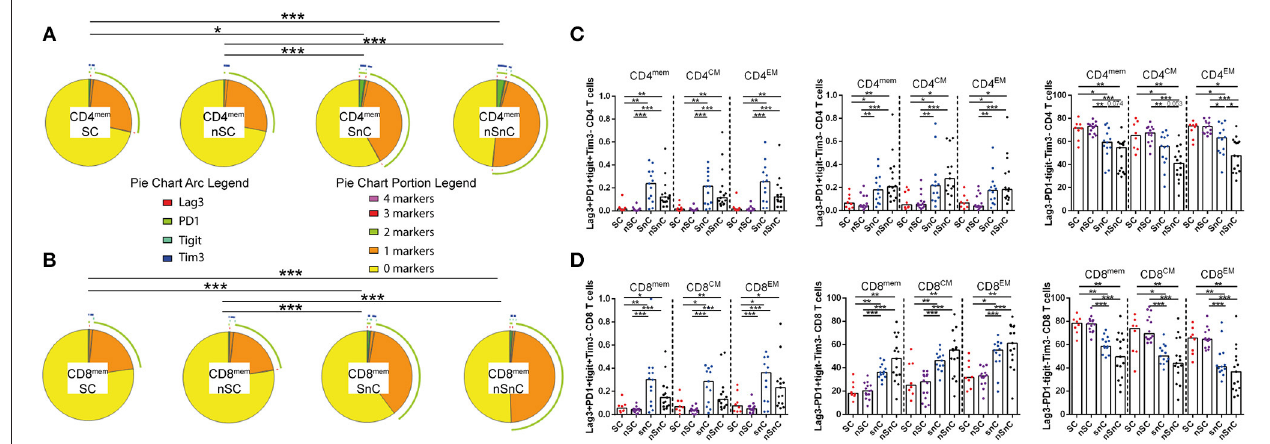
FIGURE 2 | T-cell exhaustion. (A) multiple exhaustion phenotype from CD4 memory T-cells pie charts. Permutation test, following the Spice version 5.2 software was used to assess diferencies between pie charts. (B) multiple exhaustion phenotype from CD8 memory T-cells pie charts. Permutation test, following the Spice version 5.2 software was used to assess diferencies between pie charts. (C) Combinations of exhaustion markers within CD4 memory subsets. Mann–Whitney U -tests was used to assess diferencies between groups. (D) Combinations of exhaustion markers within CD8 memory subsets. Mann–Whitney U -tests was used to assess diferencies between groups. mem, total memory; CM, central memory; EM, effector memory. SC, supercontrollers, HCV spontaneous clearers and HIV-elite controllers; nSC, non-spontaneously HCV clearers HIV-elite controllers; SnC, HCV spontaneous clearers non-HIV-elite controllers; nSnC, non-spontaneously HCV clearers non-HIV-elite controllers. Statistical values are shown as: * p = 0.05–0.01; ** p = 0.01–0.001; *** p <